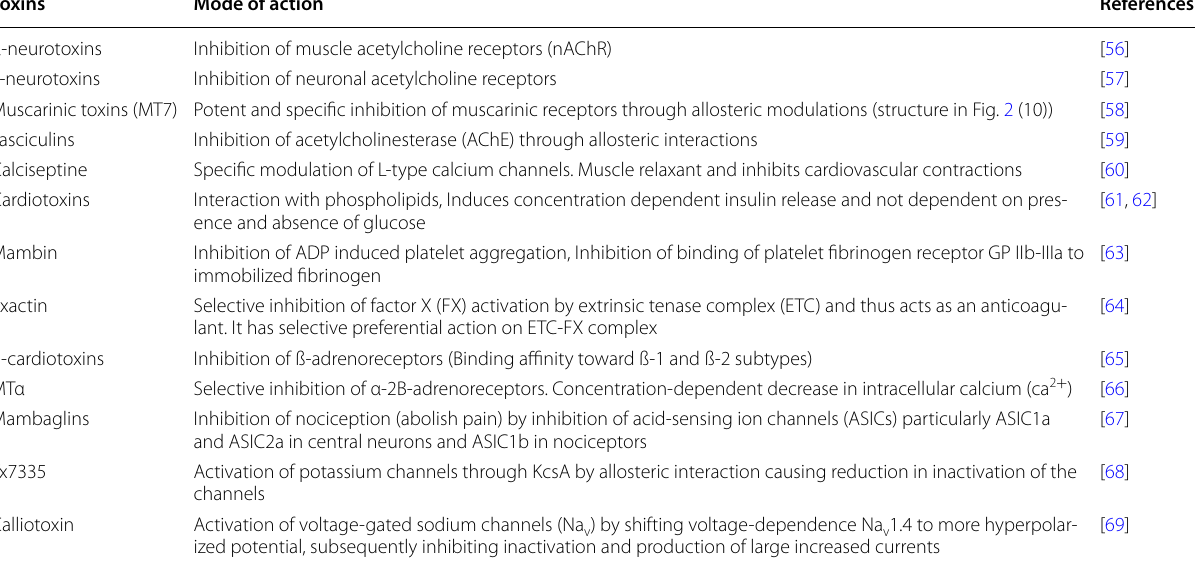
Table 1 Different types of three-finger toxins and their mode of action